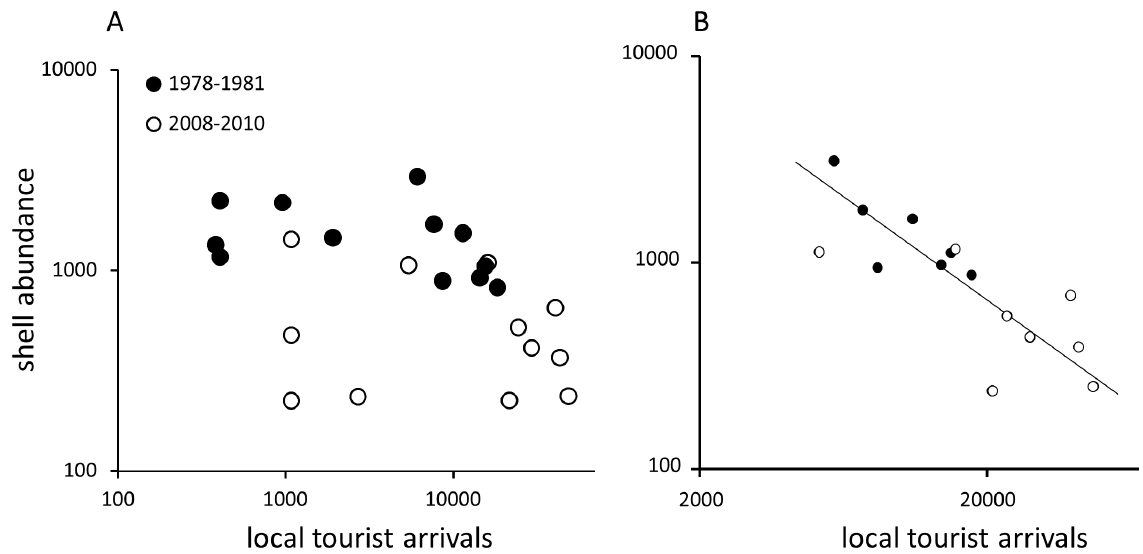
Figure 6. Log-log bivariate plots of tourist arrivals and shell abundance. Each data point represent average for the same months sampled in a given time interval (e.g., all July transects obtained in the 1978–1981 sampling period will be represented by one mean value. (a) All data; (b) Data restricted to months with tourist activity . 5000 (a solid line represents a Reduced Major Axis Regression model).